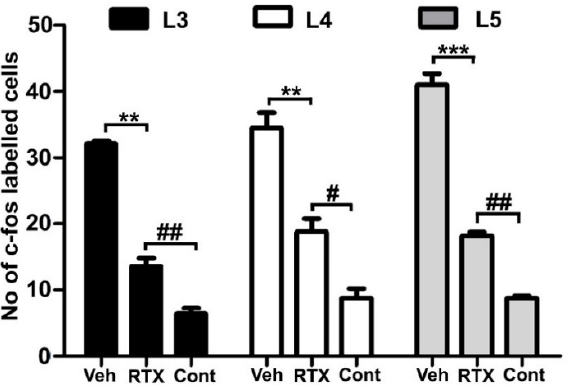
Figure 9. Images showing c-fos expression in sections of L3–L5 spinal segments 90 min after intraplantar injection of RTX (0.002%, 100 µL) in the left hind paw of rats that were administered the same amounts of RTX or vehicle injection 14 days earlier. A profound expression of c-fos was observed in the medial half areas of the L3 ( A ), L4 ( B ), and L5 ( C ) dorsal horn of the spinal cord of animals that were injected with vehicle 14 days earlier. In contrast, animals injected with RTX showed significant suppression of c-fos expression in the dorsal horn of L3 ( D ), L4 ( E ), L5 ( F ) of spinal segments. The right control sides of L3 ( G ), L4 ( H ), L5 ( I ) showed a basal level of c-fos expression (Scale bar = 200 µm).